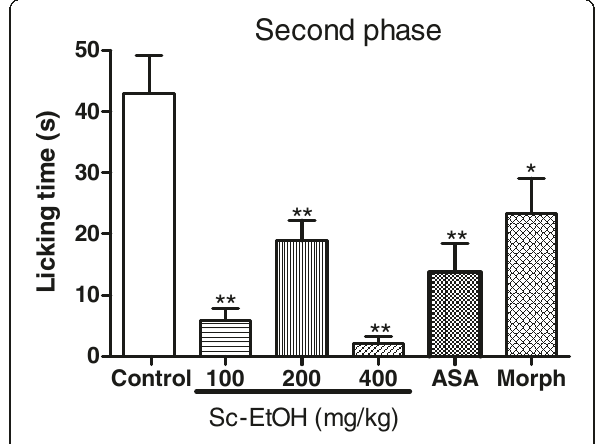
Figure 4 Effect of ethanolic extract of Selaginella convoluta (Sc-EtOH), acetylsalicylic acid (ASA 150 mg/kg) and morphine (Morph 10 mg/kg) on formalin test (second phase). Values are mean ± S.E.M.; *p < 0.05, **p < 0.01, significantly different from control; ANOVA followed Dunnett ’ s test (n = 6, per group).